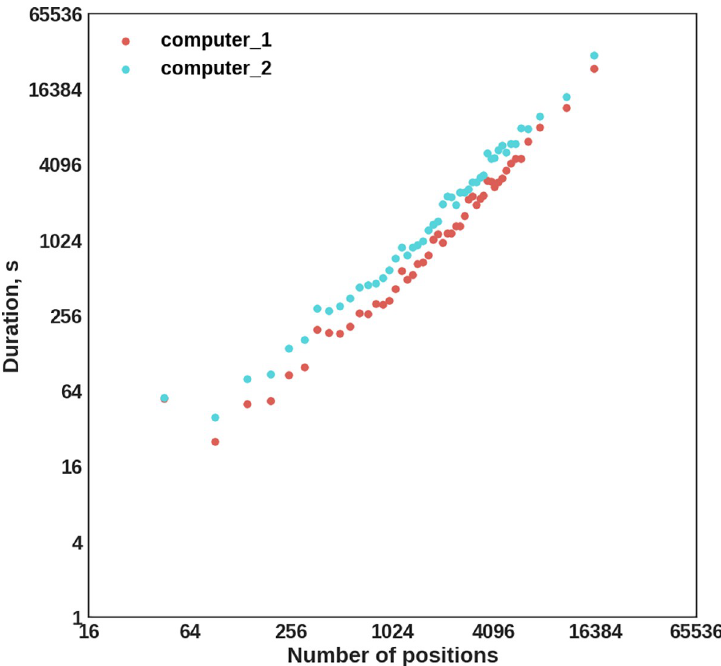
Fig 3. The NGS-PrimerPlex performance evaluated for the different numbers of BRCA1 and BRCA2 exons on two computers (computer 1: Intel Core i7-8700 3.2GHz, 64 GB RAM, Ubuntu 16.04; computer 2: Intel Core i7-2700K 3.5GHz, 32 GB RAM Ubuntu 18.04). Horizontal and vertical axes have log 2 -scale.